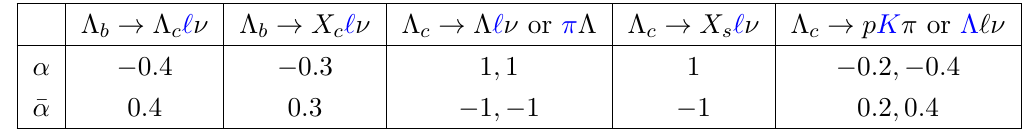
Table 1 . The values of α and ¯ α determining the sensitivity of the polarimeter particle to the spin of the hadronized quark. The polarimeter is shown in